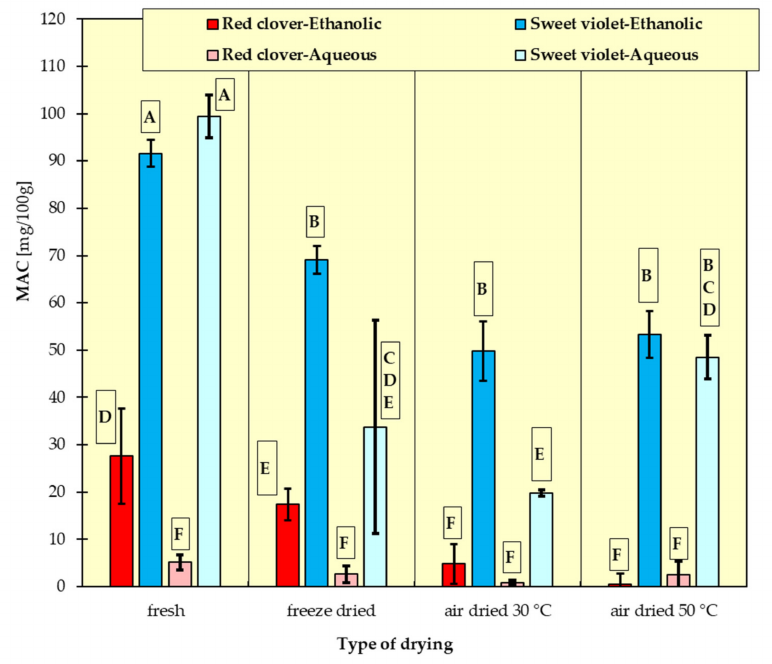
Figure 2. Anthocyanin content (MAC) in ethanolic and aqueous extracts from red clover, sweet violet and elderberry flowers. All data are expressed as mean ± SD. Bars with a different letter indicate significant differences according to HDS Tukey’s test ( p < 0.05 was accepted as statistically significant). Homogeneous groups are marked with the same letters.